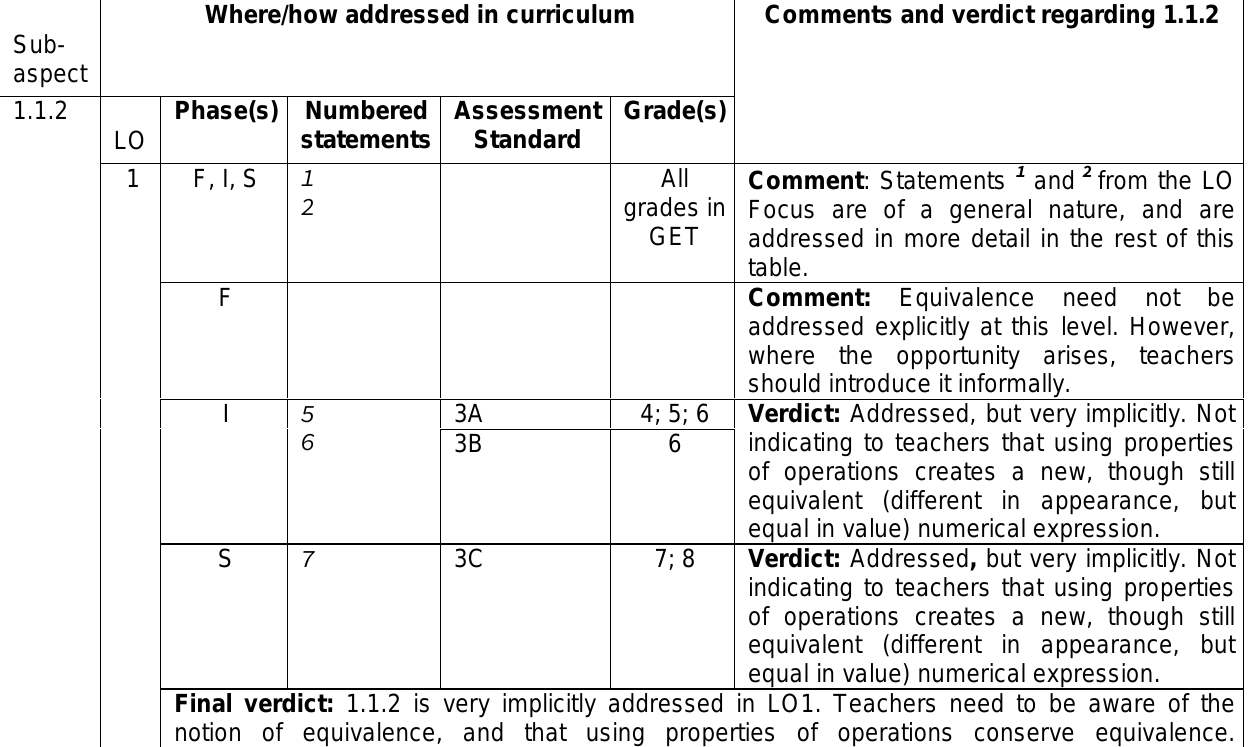
Aspect 1 (cont.): enable learners to experience and appreciate algebra as generalised arithmetic